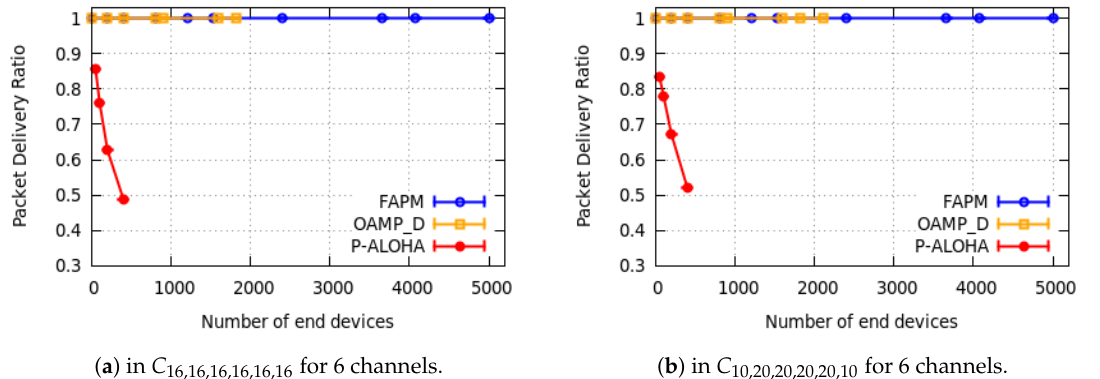
Figure 10. PDR of FAPM, OAPM_D and pure Aloha versus the number of End Devices.